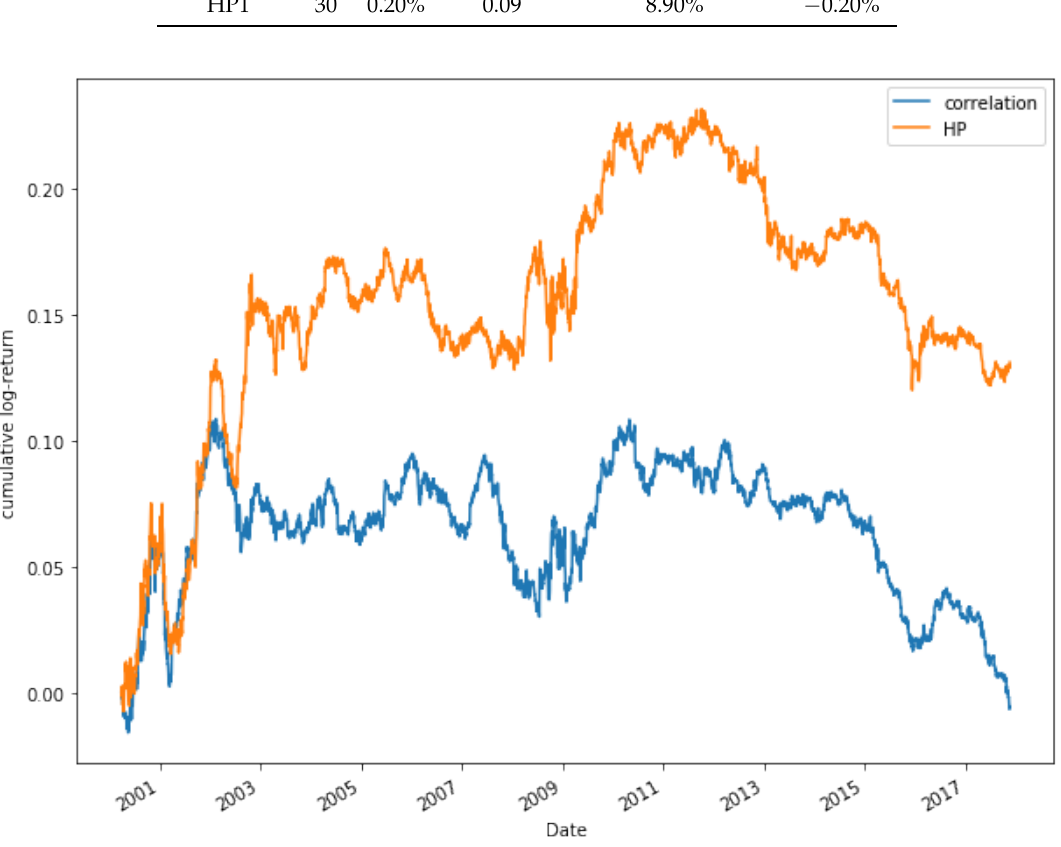
Figure 19. Comparative cumulative log-return of a 15-pair portfolio between HP (HP1 version) and Pearson’s correlation coefficient methods, of Dow Jones securities in the period